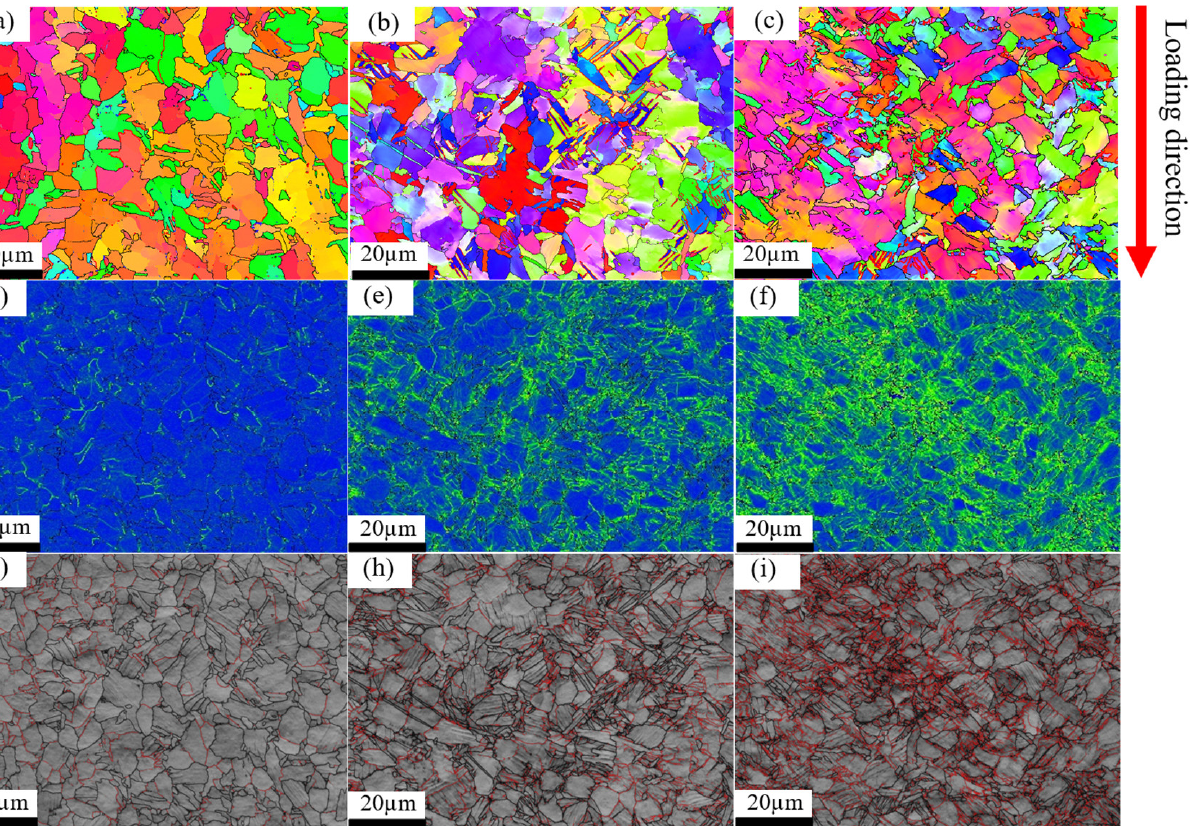
Figure 4. EBSD results: ( a – c ) inverse pole figures; ( d – f ) kernel average misorientation maps; ( g – i ) grain boundary orientations for ( a , d , g ) initial, ( b , e , h ) deformed with strain rate 1620 s −1 , and ( c , f , i ) deformed with strain rate 2820 s −1 samples.